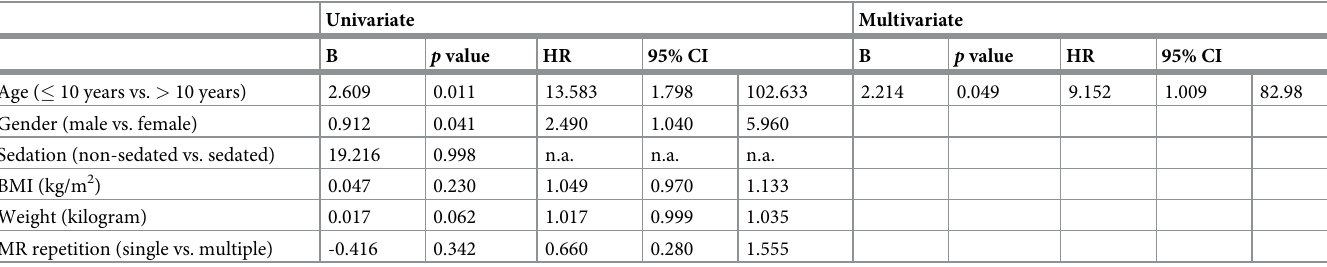
Table 2. Logistic regression analysis of factors associated with transient severe motion artifacts in the arterial